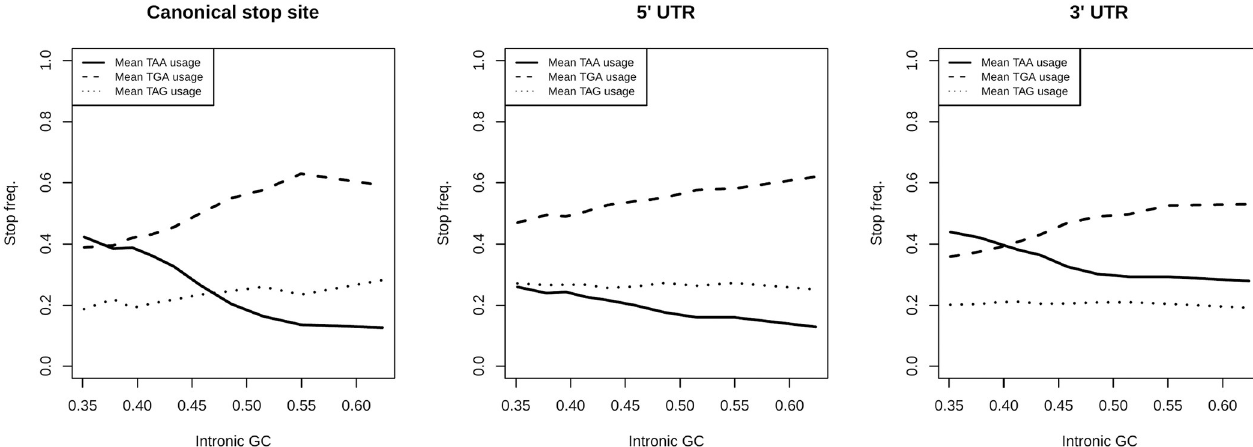
Fig 1. Stop codon frequencies (relative to the usage of all stops) at the canonical stop site, in the 5 0 UTR, and in the 3 0 UTR at 10 equal-sized bins of various intronic GC contents in the genome. TAA frequency is negatively correlated with intronic GC content in all 3 sequences (Spearman’s rank; all p < 2.2 × 10 –16 , all rho = –0.99, n = 10). TGA is positively correlated with intronic GC content in all 3 sequences (Spearman’s rank; all p < 2.2 × 10 –16 , rho = 0.99 for CDS, rho = 1 for both UTRs, n = 10). TAG usage is positively correlated with intronic GC content at the canonical stop site (Spearman’s rank; p = 0.0014, rho = 0.89, n = 10) but is uncorrelated with intronic GC content in both 5 0 (Spearman’s rank; p = 0.10, rho = 0.55, n = 10) and 3 0 UTR sequences (Spearman’s rank; p = 0.61, rho = 0.19, n = 10). Underlying data can be found in S1